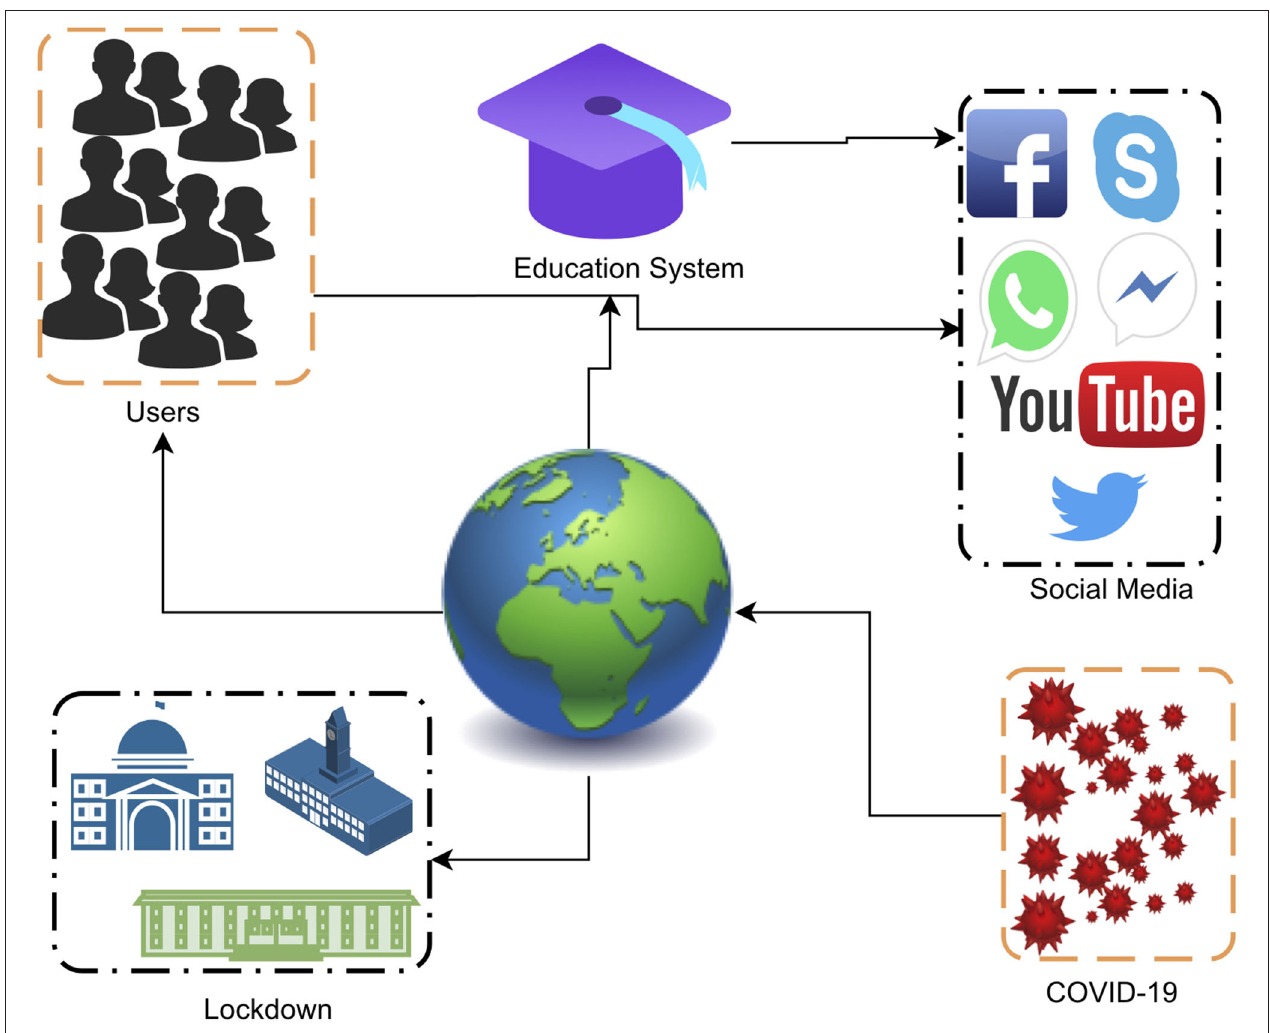
FIGURE 1 | Social media adoption during the COVID-19